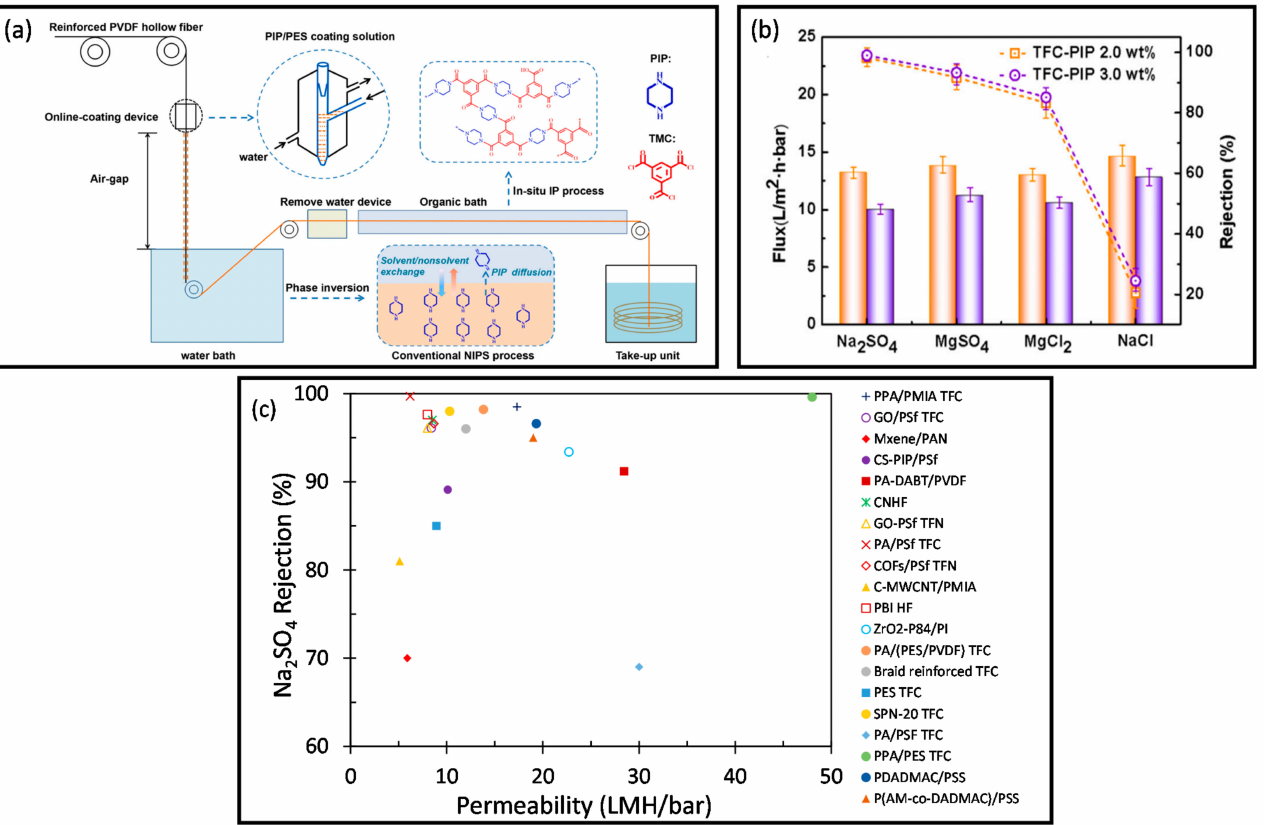
Figure 10. ( a ) The illustration of the synthesis procedure of PA/(PES/PVDF) TFC hollow fiber membrane and ( b ) various salt rejection of PA/(PES/PVDF) membrane. Reprinted/adapted with permission from Ref. [86]. Copyright 2021, Elsevier. ( c ) Performance plot of Na 2 SO 4 rejection in